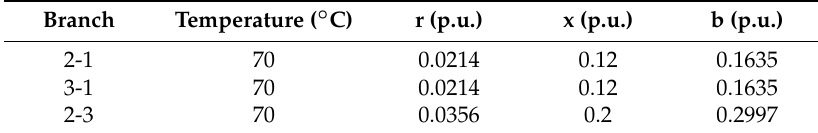
Table 4. The impedance and susceptance when the conductor temperature is 70 ◦ C.